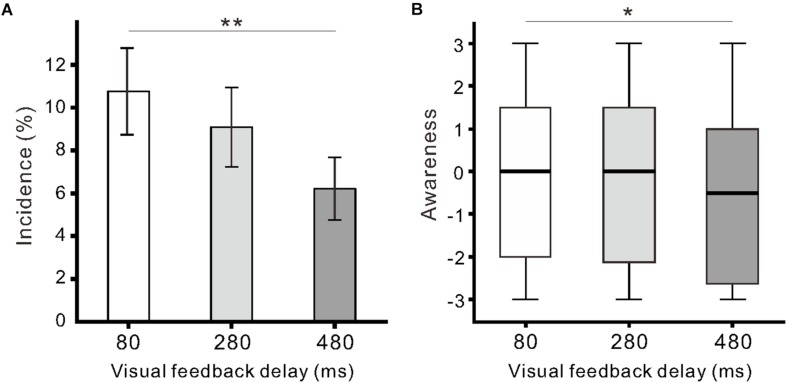
Participant finger movement evoked by the observation of model hand movement. (A) Mean incidence of finger movement against the delay conditions. Vertical lines denote ± 1.0 SE. (B) Boxplots of the questionnaire rating (Awareness) regarding finger movements. Significance is denoted using asterisks (∗∗p < 0.01; ∗p < 0.05).